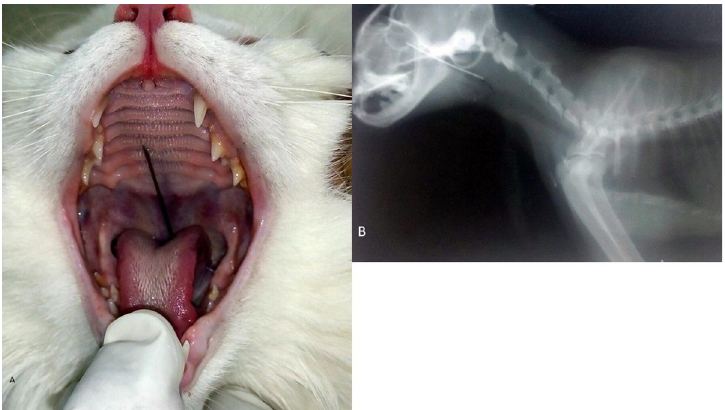
Fig 1. Clinical and radiographic findings regarding oesophageal foreign bodies at the oesophageal entrance (cervical region). a. Clinical photograph of mixed breed cat showing protruded sewing needle in oral cavity. b. Lateral radiographic view of cat showing radiopaque needle.